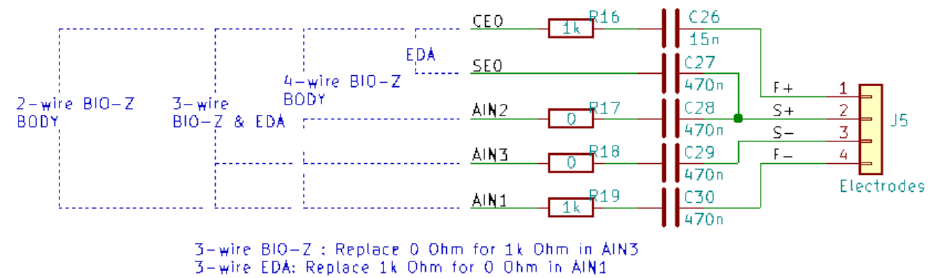
Figure 8. Connection of the electrodes for the three measurement modes, 2, 3 and 4 electrodes. Limiting/isolation resistors are included. This figure has been generated with KiCAD (https:// www.kicad.org, accessed on 14 June 2022). See the text for an explanation of the two, three and four wire